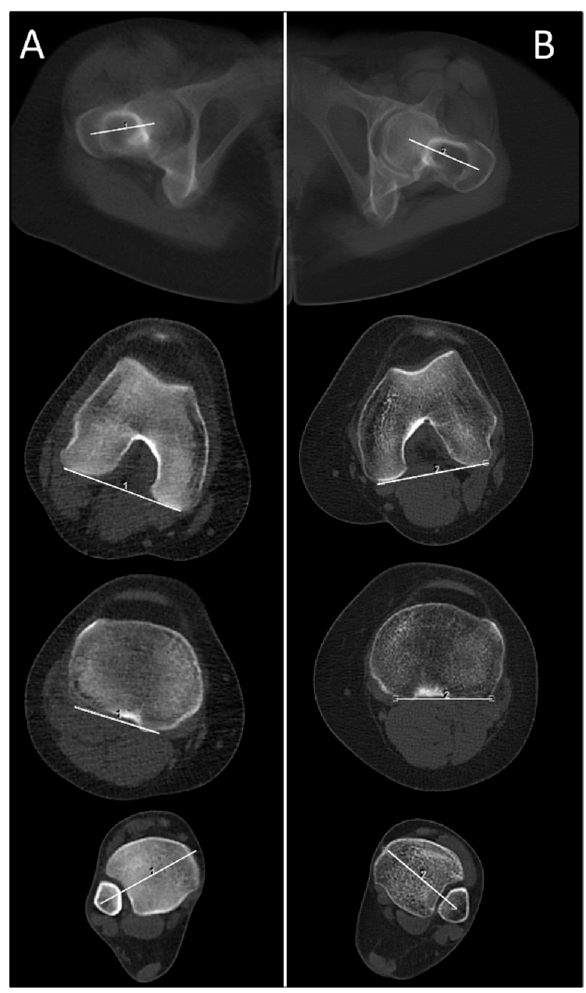
Figure 1. Comparison of a patient ( A ); female, 17 years, BMI = 25.2 kg/m 2 , no metal implants, total dose equivalent = 0.19 mSv examined with the newly introduced ultra-low dose (ULD) study protocol and a patient ( B ); female, 37 years, BMI 23.8 kg/m 2 , no metal implants, total dose equivalent = 4.09 mSv examined with the previous standard high-quality (HQ) study protocol for CT-torsion measurement (BMI = body mass index).